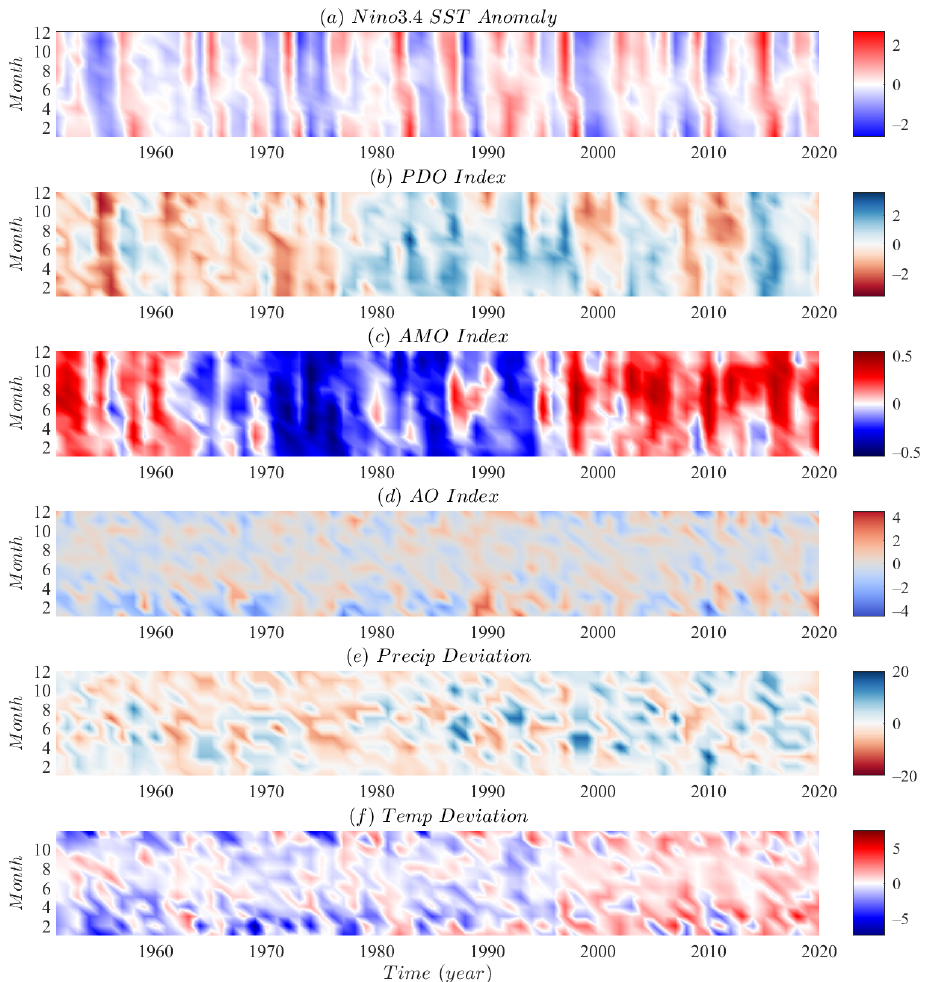
Figure 4. Year month matrix maps for ( a ) NINO3.4 index; ( b ) PDO index; ( c ) AMO index; ( d ) AO index; ( e ) monthly precipitation deviation from the long-term average rainfall of the correspond- ing month; and ( f ) monthly temperature deviation from the long-term mean temperature of the corresponding month. The vertical axis denotes months from 1 January to 12